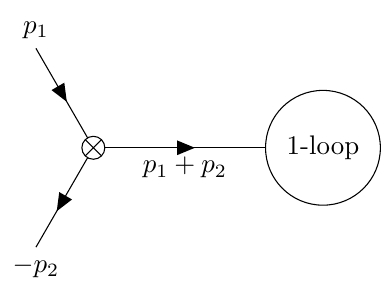
Figure 7 . This diagram is responsible for non-universal holomorphic collinear singularities in the 1-minus amplitudes of a particular 1 st -order deformation of SD